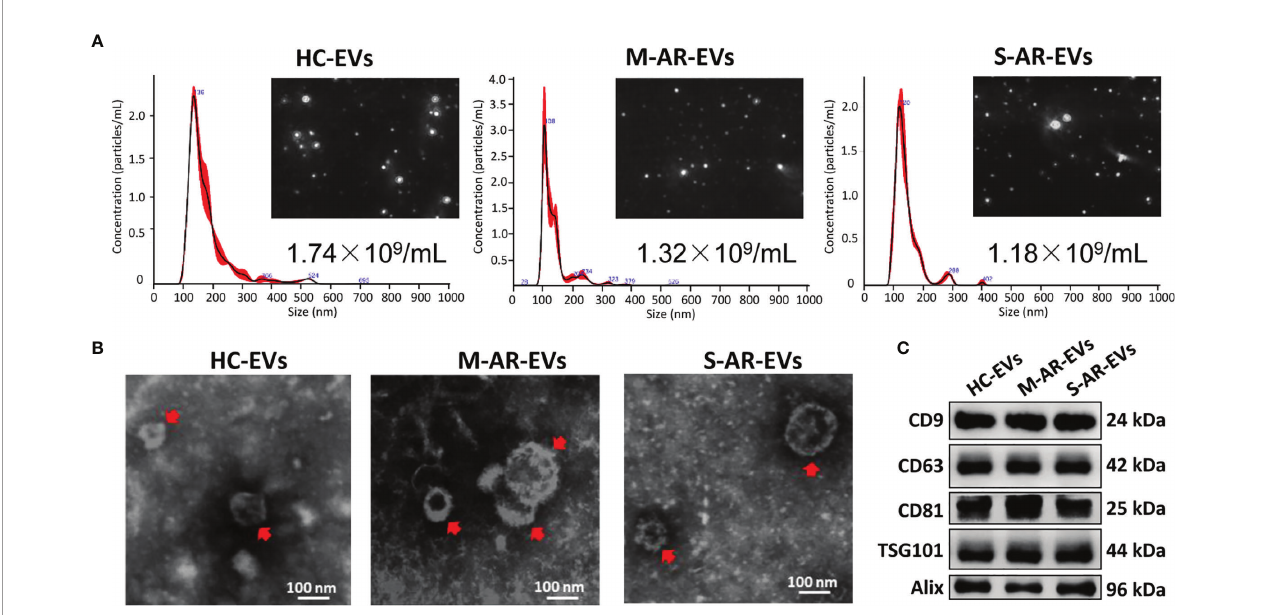
FIGURE 1 | Characterization of plasma EVs. (A) Nanoparticle tracking analysis for determination of the particle numbers and size distribution of plasma EVs. (B) Transmission electron microscopy for characterization of the morphology of plasma EVs. (C) Plasma EVs isolated from HC subjects and patients with M-AR and S-AR were positive in the expression of speci fi c EV markers. HC, Healthy control; M-AR, Mild allergic rhinitis; S-AR, Moderate-severe allergic rhinitis.